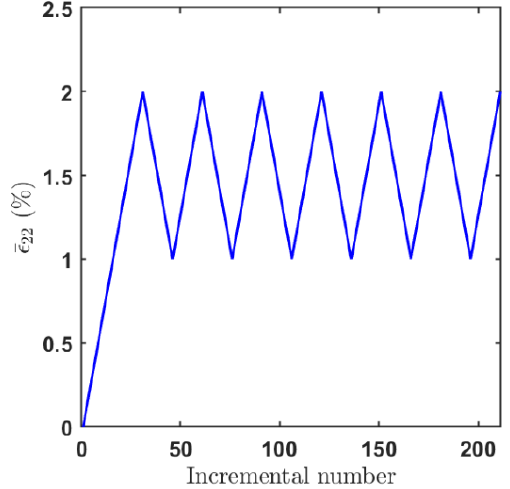
Figure 8. Cyclic loading